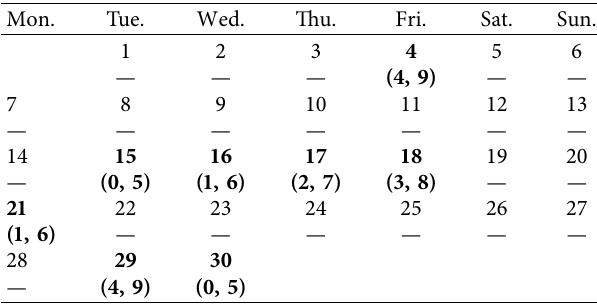
Table 1: The ODPW policy implementation in November 2016 in Xi’an. Mon. Tue. Wed. Thu. Fri.